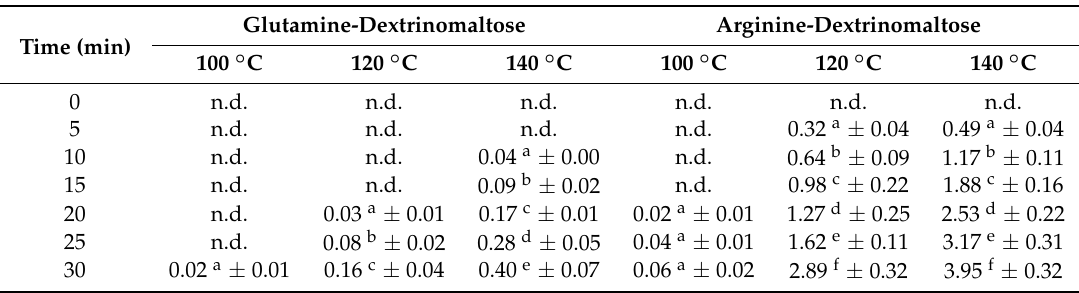
Table 3. Furfural content (mg · L − 1 ). Values are means ± SD, n = 3; Different letters within a column indicate significant differences between groups ( p < 0.05); n.d. = not